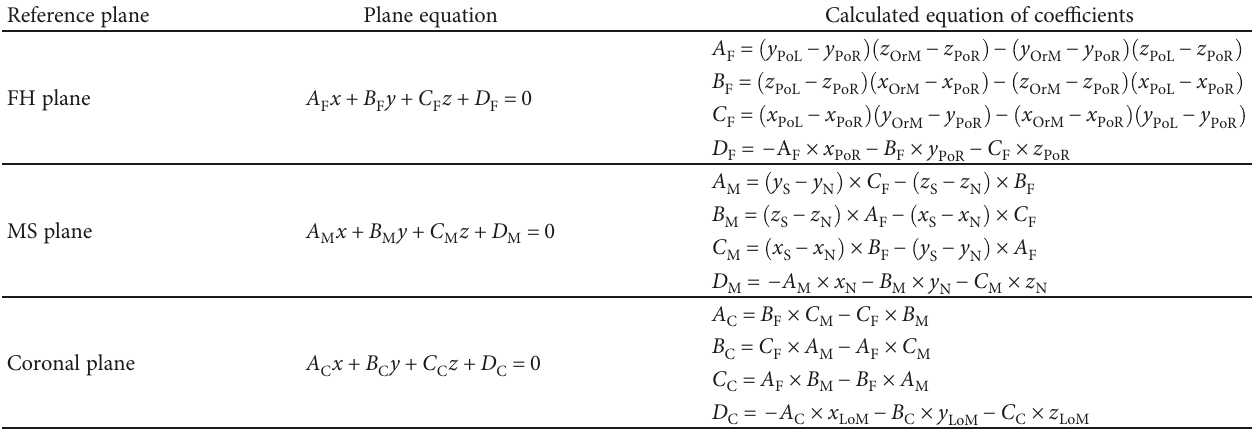
Table 2: The calculation equations of the reference planes. All the coordinate values used for calculation were STL coordinates of MIMICS. Reference plane